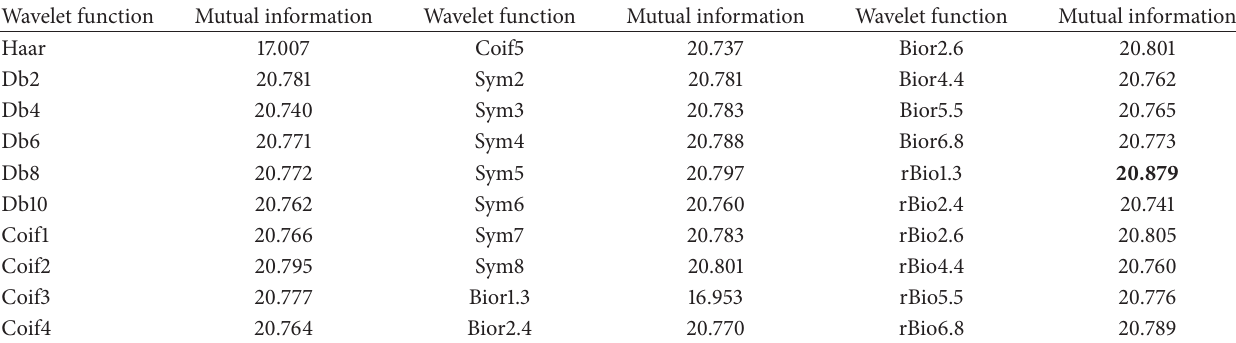
Table 2: Mutual information of the extracted bearing vibration signal using different wavelets.